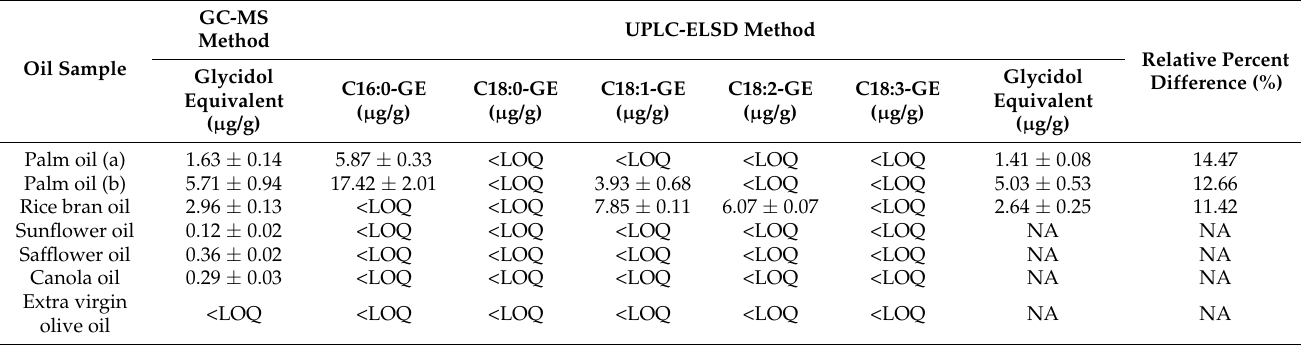
Table 6. Contents of glycidyl esters (GEs) in edible oils determined by the UPLC-ELSD method and Cd 29a-13 GC-MS method.